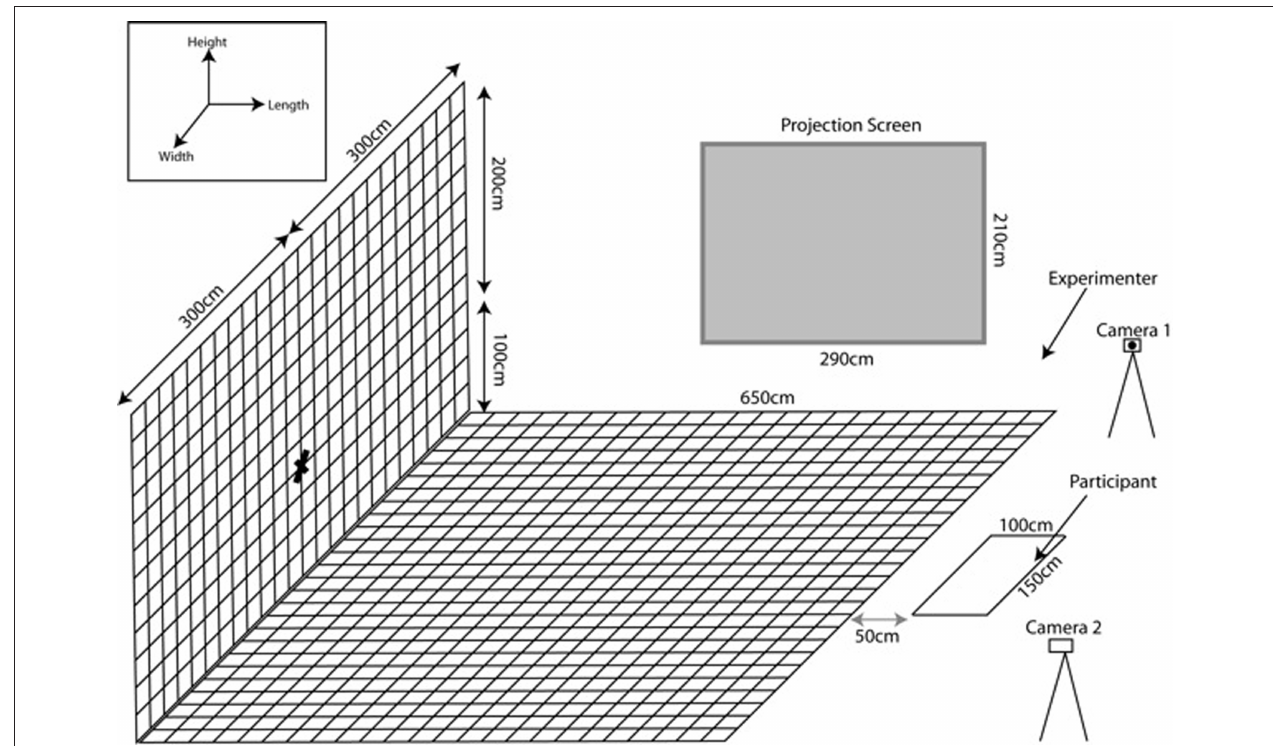
Figure 1 | Schematic of the experimental setup showing the positions of the participant, cameras and projection screen and the layout of the scoring grid and target position (black cross).